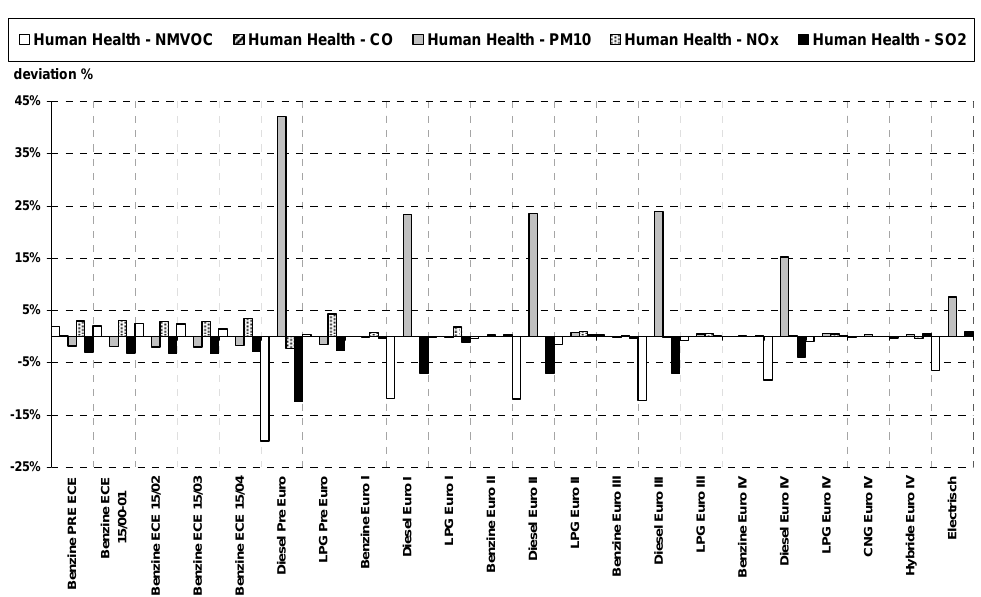
Figure 6. Sensitivity of each impact contribution for the Ecoscore methodology The largest change of the total impact is obtained for diesel vehicles, when doubling the contribution of particulate matter (PM10) to the human health impact category. This means that in the case of diesel vehicles, the result of the Ecoscore methodology is significantly influenced by this pollutant, because of its important impact on the health of people. This observation is corresponding to the high external cost of particulate matter, used in the damage characterisation. To evaluate the robustness of the methodology and the relative positioning of the assessed vehicles, it is important to characterise the influence of the models’ sensitivity on the end result for the assessed vehicle. The results of the sensitivity analysis are presented in figure 7. The environmental indicator Ecoscore was calculated and the range of results (up to their maximum deviation), are indicated with an error bar. These analyses indicate a high robustness of the methodology for vehicles complying with the latest emission levels. Older vehicles and diesel vehicles show a larger sensitivity for errors on emission values and/or damage